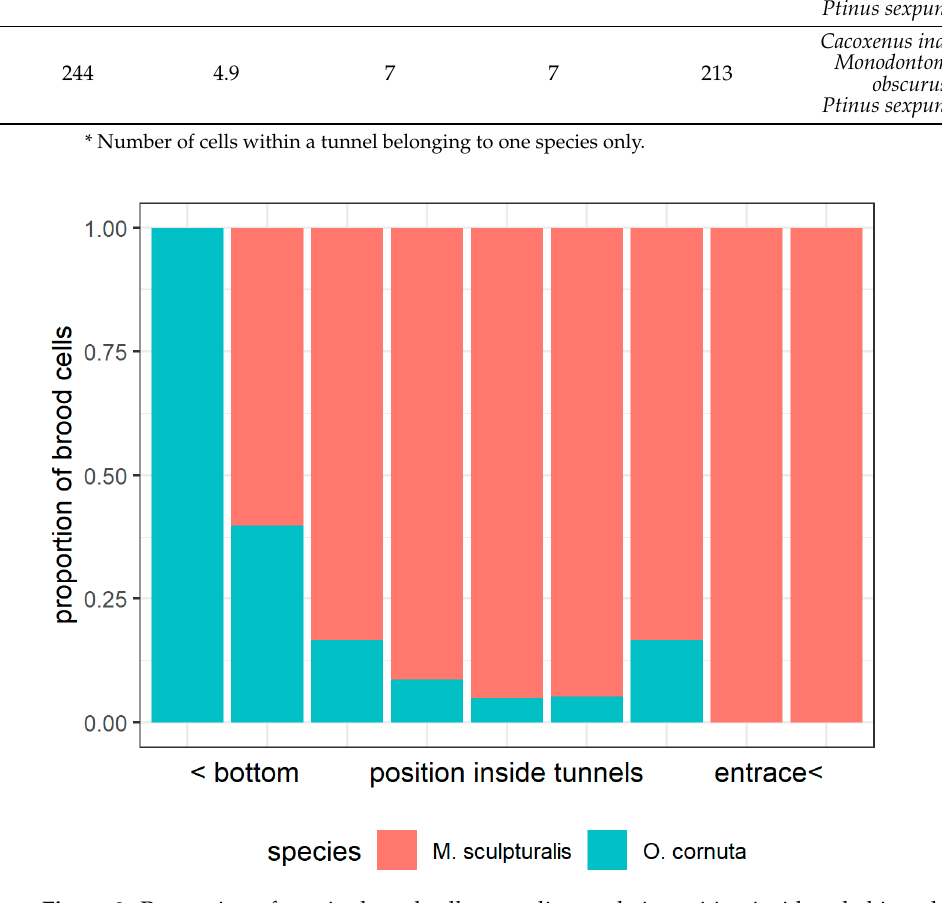
Figure 2. Proportion of species brood cells according to their position inside cohabitated tunnels, with a maximum of nine occupied positions (from the bottom to the entrance).